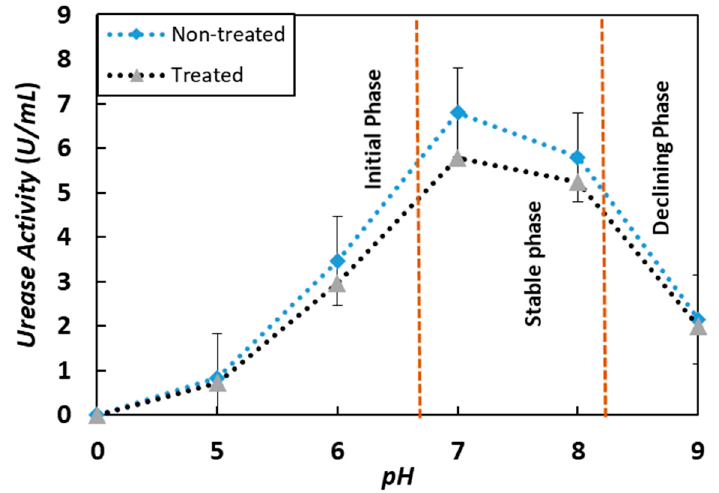
Figure 6. Urease activity varying with pH.